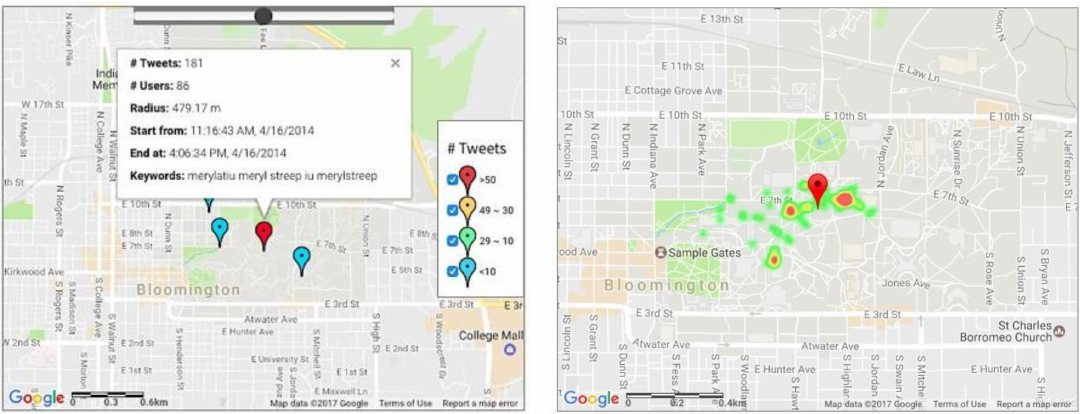
Figure 10. Clusters of the tweets about Meryl Streep’s visit to Indiana University on 16 April 2014 and the tweets distribution of the most significant cluster.